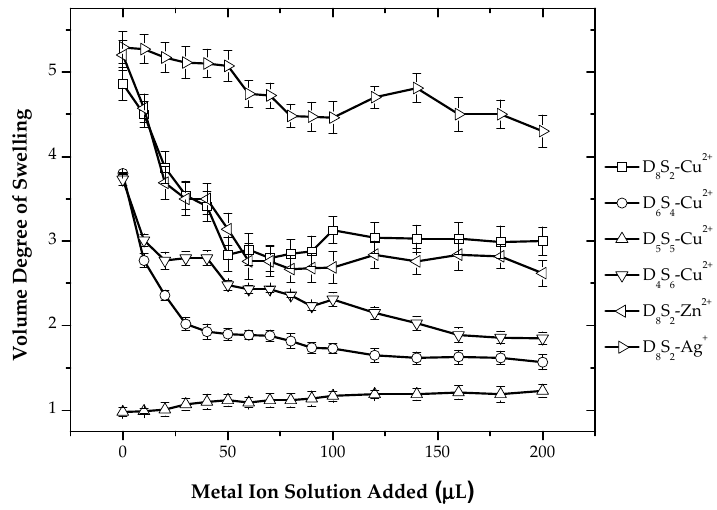
Figure 8. Variation of the volume degree of swelling with respect to varying amounts of CuSO 4 solution (0.01 M) for all compositions of hydrogels and variation of the volume degree of swelling of D 8 S 2 hydrogels with respect to the addition of different metal ions for System III